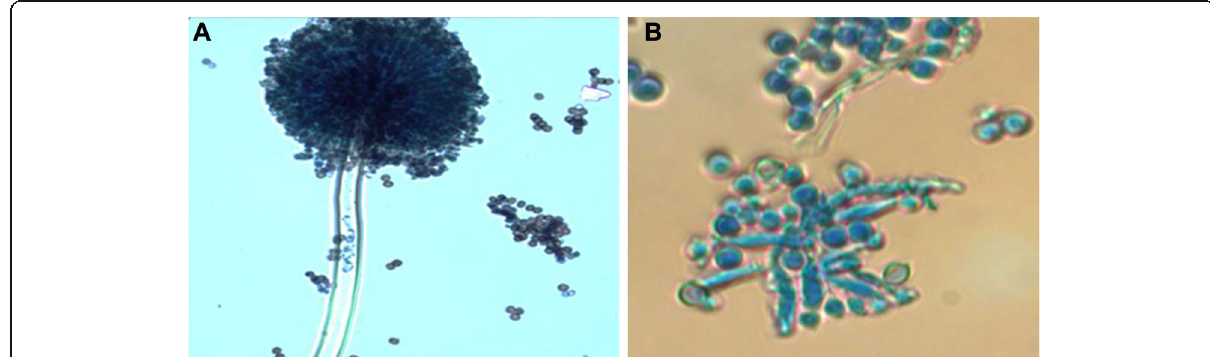
Fig. 3 Microscopic view of a Aspergillus niger A6 and b Eurotium amstelodami CASMB-SEF 9